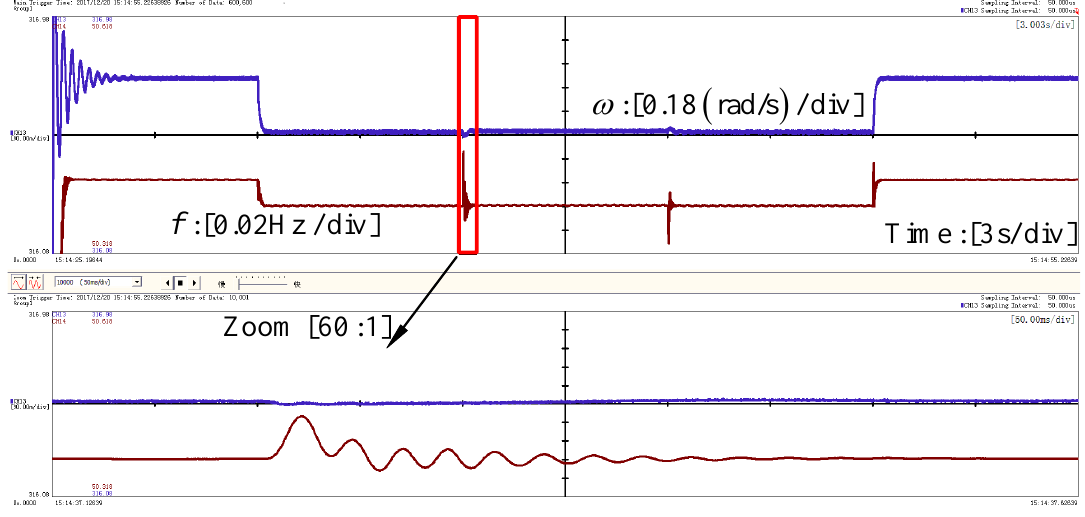
Figure 15. Experiment results of the system frequency: the frequency f from extra PLL circuit; and the angular frequency reference ω .